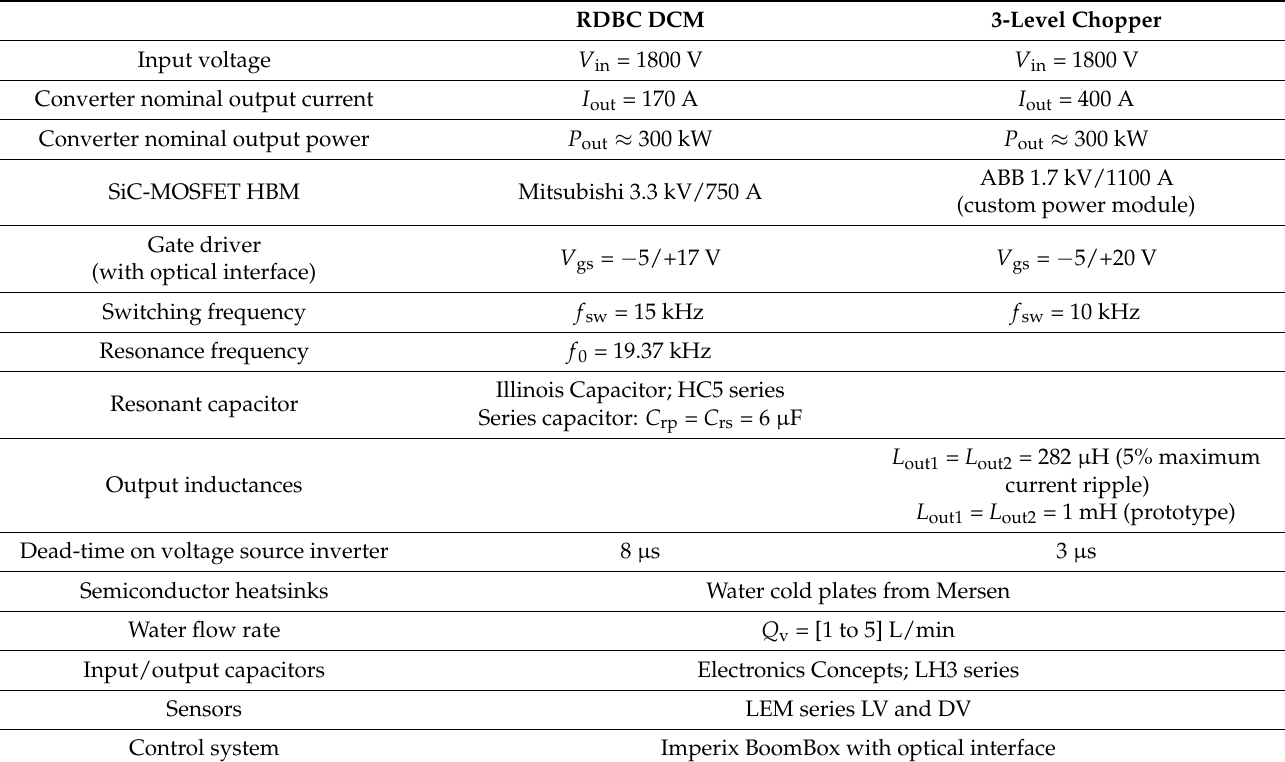
Table 1. Isolated DC/DC converter prototype: RDBC DCM and 3-level chopper specifications. RDBC DCM 3-Level Chopper